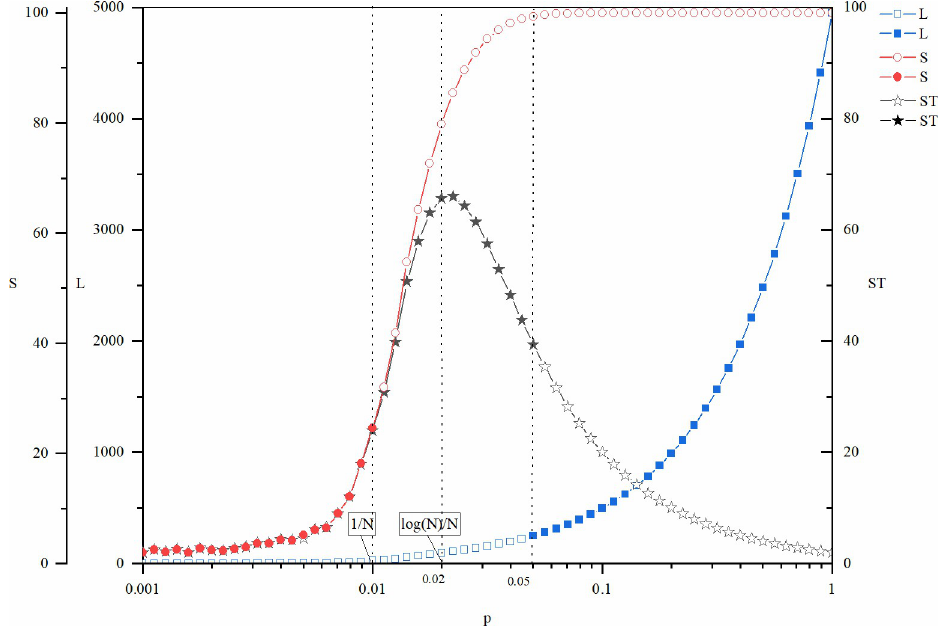
Fig 5. Innovation branch structure characteristics of exploitative